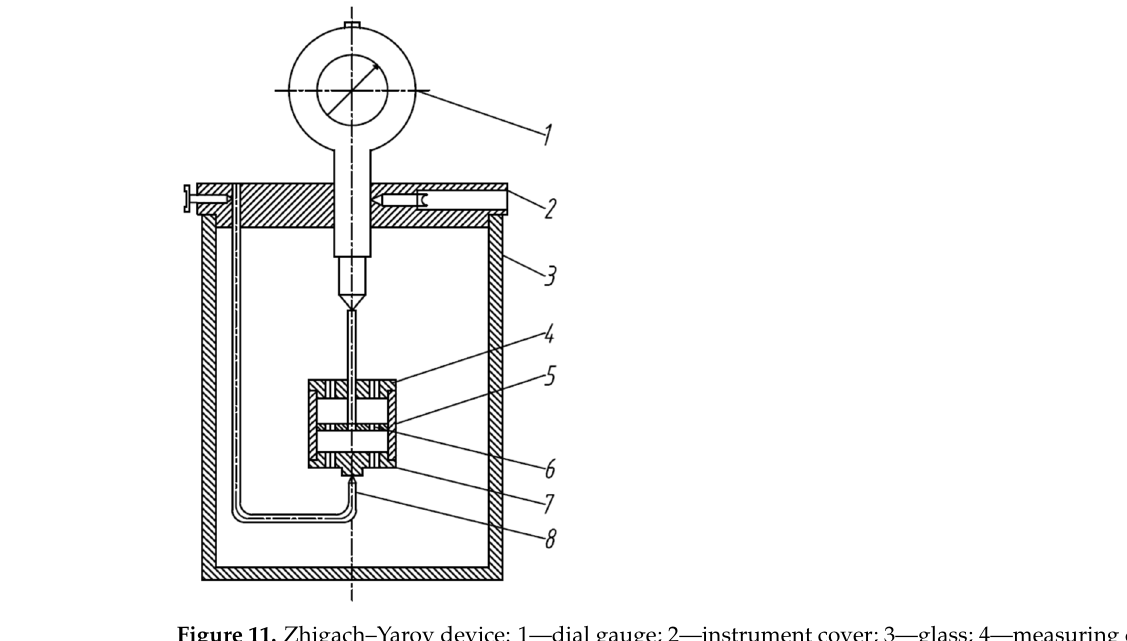
Figure 10. Dial gauge [77].